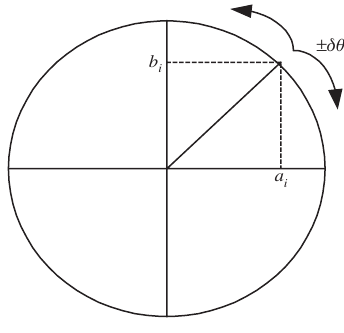
Figure 8. Quantum